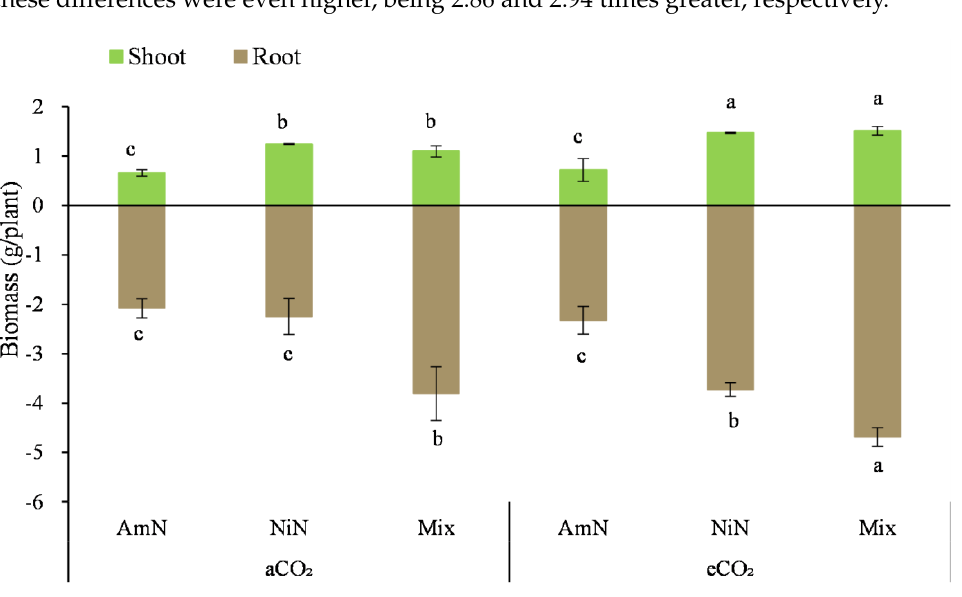
Figure 1. Biomass of wheat supplied with different N forms under two atmospheric CO 2 concentra- tions. Note: (1) AmN denotes Ammonium N, NiN denotes Nitrate N, Mix denotes Mixed N; (2) aCO 2 denotes the ambient atmospheric CO 2 concentration at 390 µ mol/mol; eCO 2 denotes the enriched atmospheric CO 2 concentration at 690 µ mol/mol; (3) Different letters mean significant differences at p < 0.05 level for each indice; (4) Statistical analyses for above- and belowground are conducted separately; (5) Error bars are the standard deviation of five replicates. Table 4. Two − factor ANOVA analyses for wheat biomass.